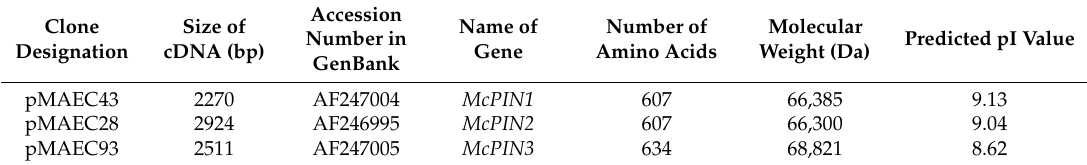
Table 1. Properties of auxin efflux carrier homologous genes isolated from bitter gourd.